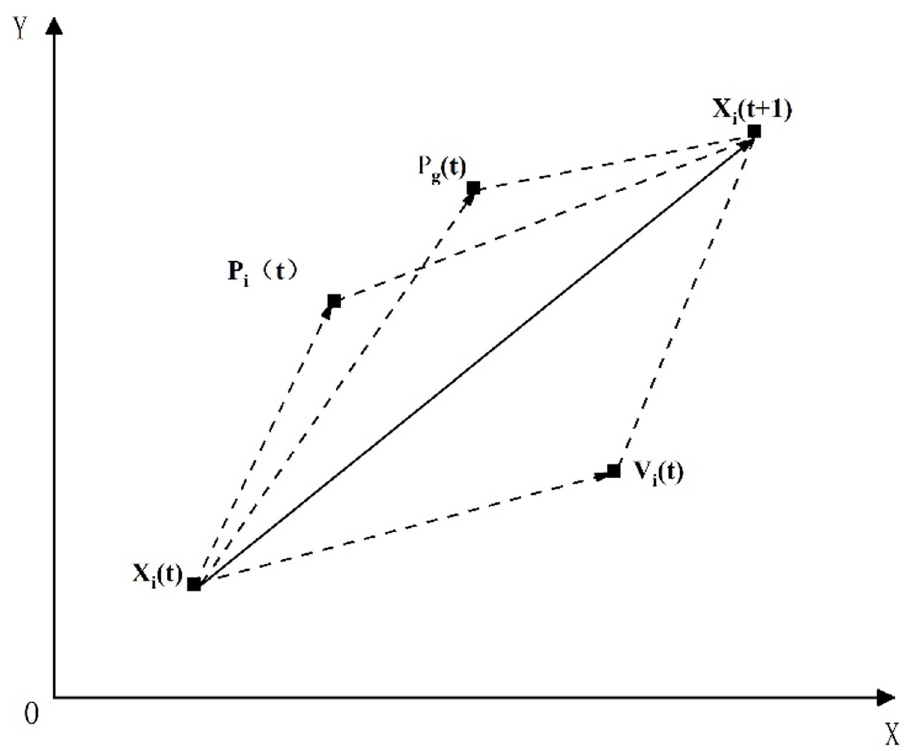
Fig 1. Mechanism of particle movement in